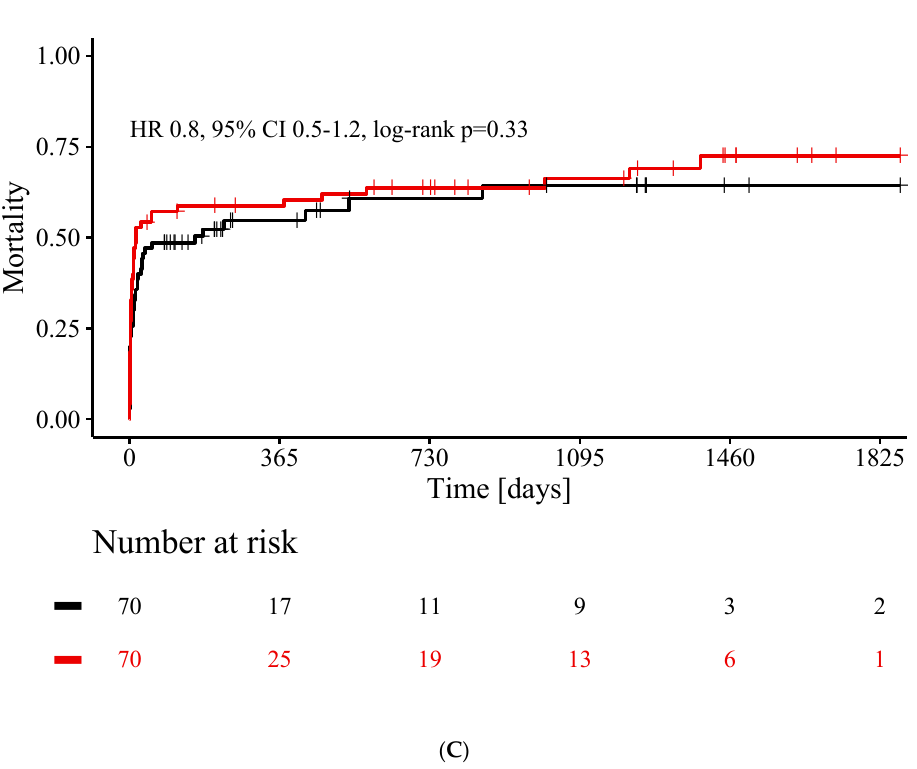
Figure 2. Mortality of patients with cardiogenic shock treated without cardiocirculatory support versus patients treated with Impella CP. Cumulative incidence curves of deaths for patients without cardiocirculatory support (black) and with Impella support (red) 30 days ( A ), 1 year ( B ) and 5 years ( C ) after the index event. Hazard ratio and 95% confidence interval is displayed for conventional group. HR, hazard ratio; CI, confidence interval.